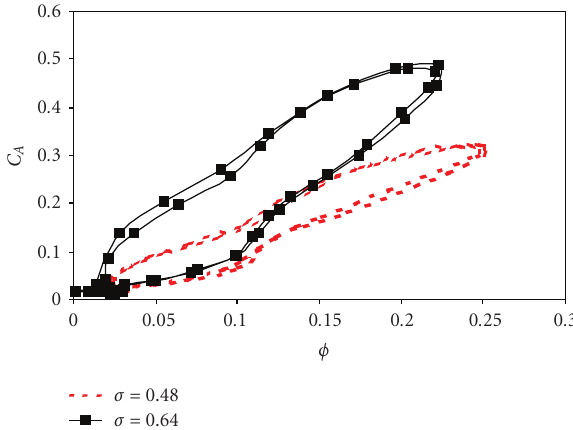
Figure 13: E ff ect of solidities on the hysteretic characteristics of CA9 under real sea conditions (site2) at 1 /κω ∗ = 0 . 2, σ = 0.64.